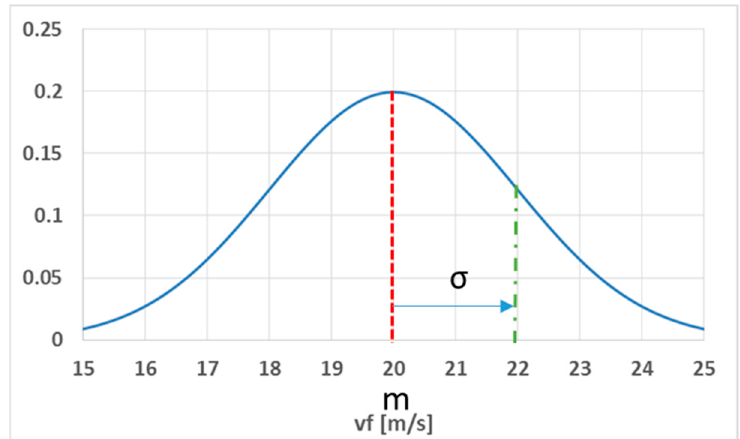
Figure 16. Normal pdf input for the chimney exit flow velocity.